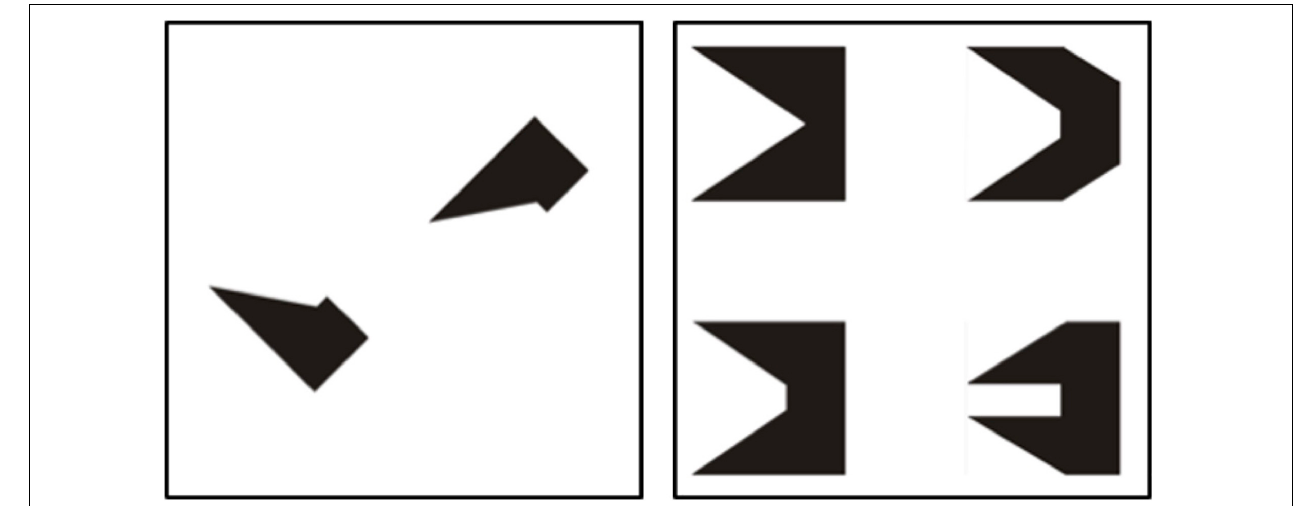
FIGURE 2 | A sample item of the Children’s Mental Transformation Task (Ehrlich et al.,